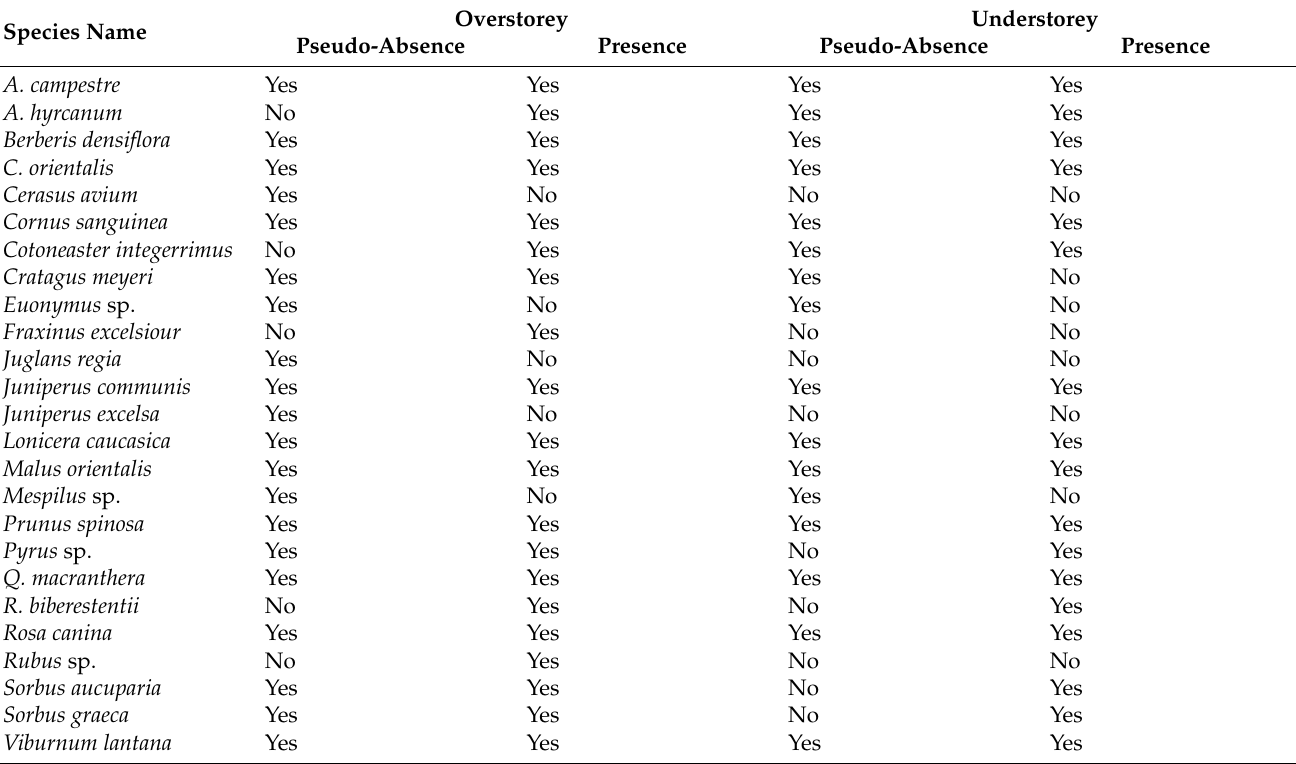
Table 2. The overstorey and understorey species observed in the pseudo-absence and presence locations of Caucasian